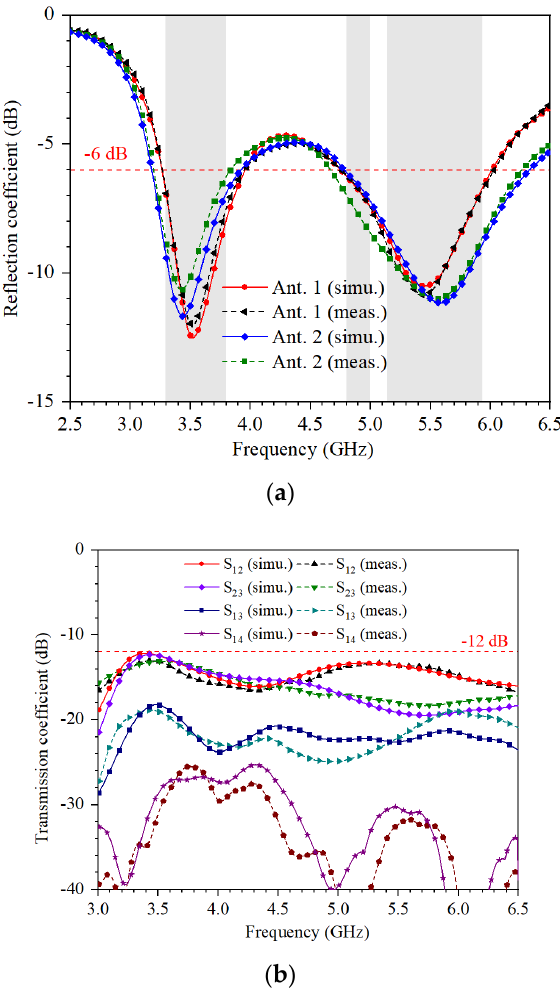
Figure 6. Simulated and measured coefficients of the proposed antenna array: ( a ) simulated and measured reflection coefficient; ( b ) simulated and measured transmission coefficient.